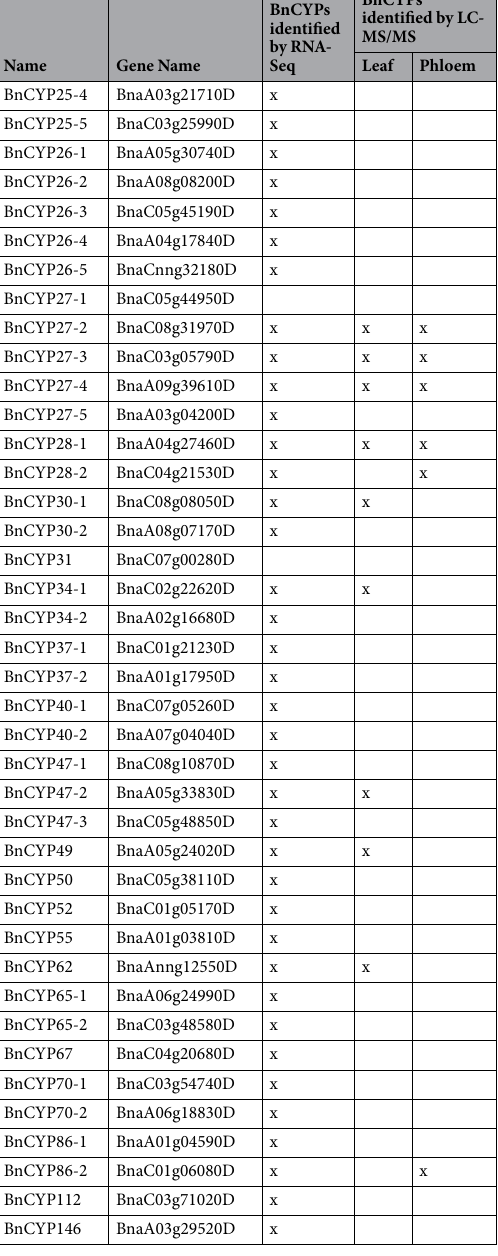
Table 3. Identified B. napus cyclophilins by RNA-Seq and